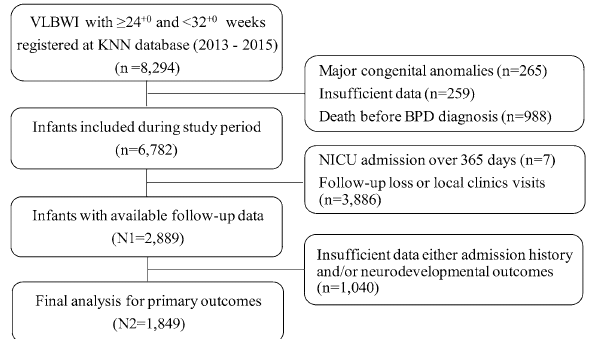
Figure 1. A total of 8294 infants born between 24 +0 weeks and 31 +6 weeks GA were enrolled in this study.